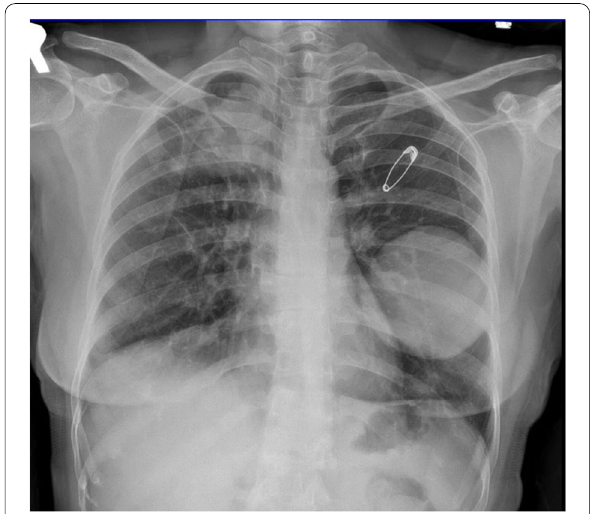
Fig. 1 Posteroanterior radiograph of the chest showing a rounded opacity in the left middle and lower lung zones, suggesting a hydatid lung cyst. Similar smaller opacity is also noted in the right upper lung